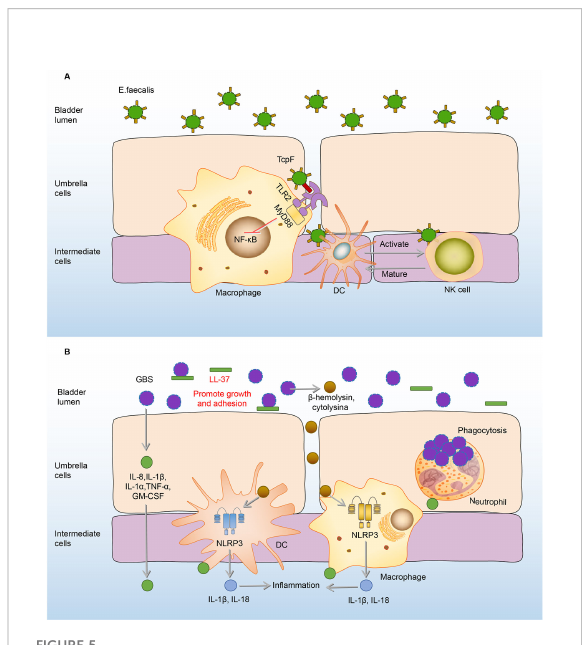
FIGURE 5 Immune responses to E. faecalis and GBS in the bladder. (A) Initially, RNase 7 in the urine binds to the E. faecalis and plays a bactericidal effect. Once E. faecalis adheres to BECs, TcpF of which binds to the TIR on macrophages, eliminating downstream MyD88 and NF-kB signals and suppressing the immune responses. However, the proliferation and activation of NK cells are intensi fi ed, which promote the maturation and differentiation of DCs. In turn, NK cells can be speci fi cally activated to kill E. faecalis through derived effectors signals from infected DCs. (B) In the urine, LL-37 sticks to GBS and promotes its growth and adhesion. After adhesion, GBS induces the expression of IL-8, IL-1 b , IL-1 a , IL-6, TNF- a , GM-CSF to recruit immune cells and mediate in fl ammation. Macrophages and DCs secrete IL-1 b and IL-18 against the GBS infection under the activation of the NLRP3 in fl ammasome by b -hemolysin/cytolysin of GBS. Neutrophils engulf GBS to play an antibacterial effect. DCs, dendritic cells; E. faecalis , Enterococcus faecalis ; GBS, Group B Streptococcus ; GM-CSF, granulocyte-macrophage colony-stimulating factor; IL-8, interleukin-8; MyD88, myeloiddifferentiationfactor88; NF-kB, Nuclear factor kappa beta; NK cells, natural killer cells; NLRP3, NOD-like receptor thermal protein domain associated protein 3; RNase 7, ribonuclease 7; TcpF, TLR2-Toll/Interleukin-1 receptor domain- containing protein of E. Faecalis